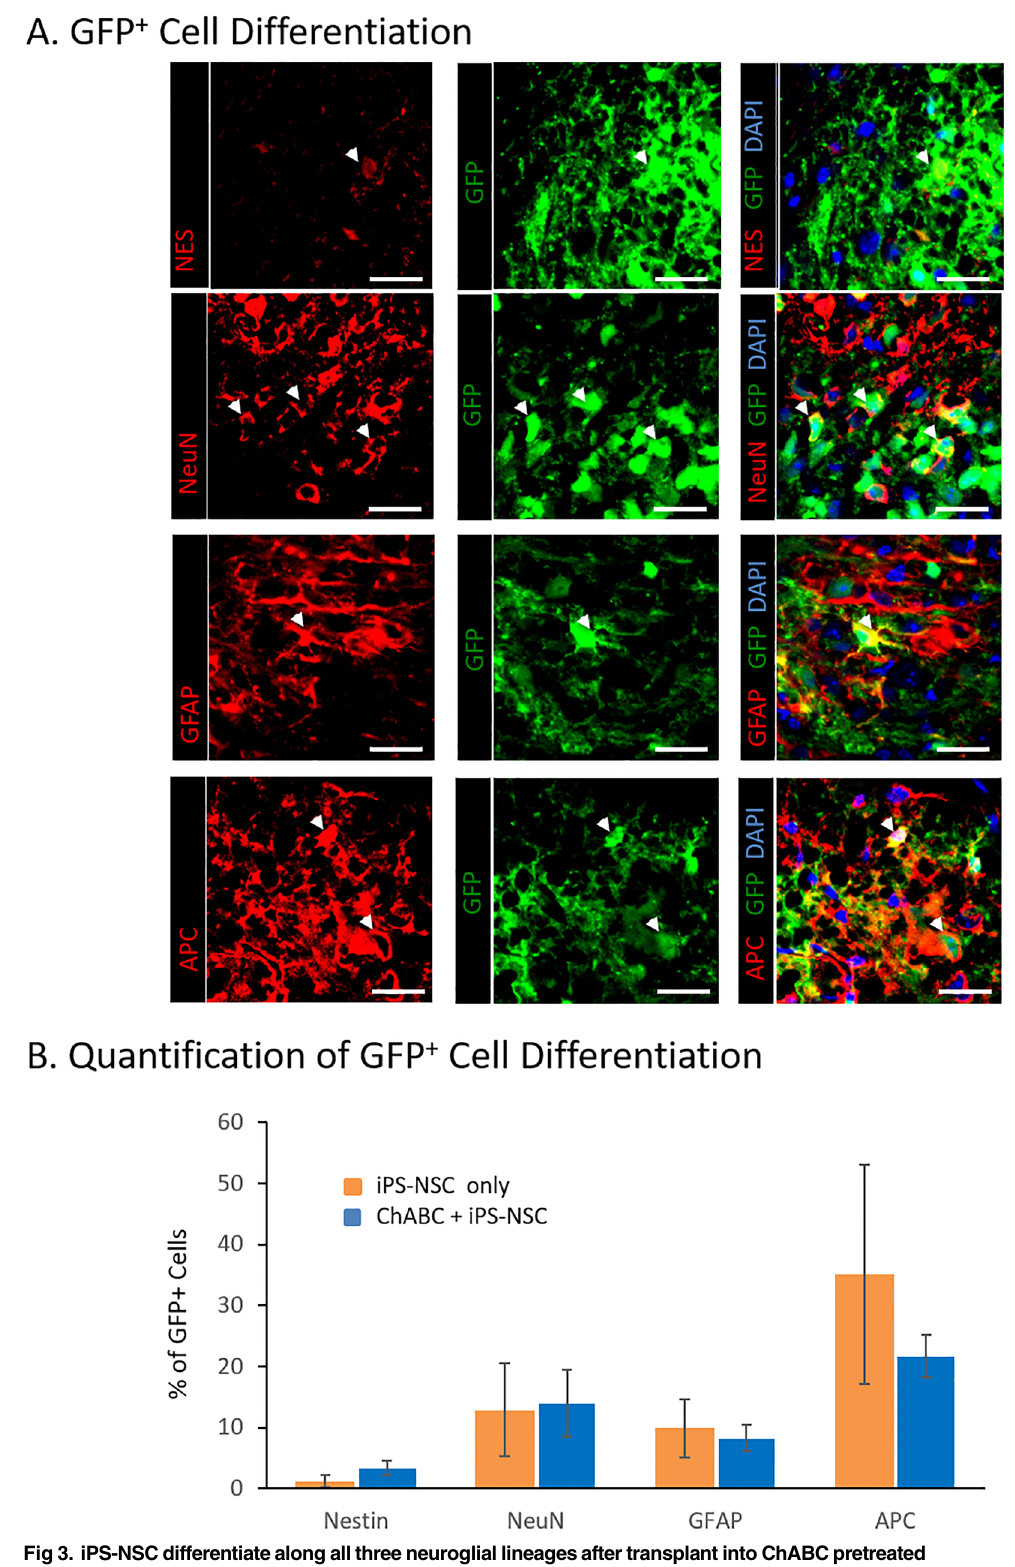
Fig 3. iPS-NSCdifferentiatealong all threeneuroglial lineagesaftertransplant into ChABCpretreated chronically injured spinal cords. (A) Immunofluorescenceimagingdemonstratingundifferentiatedneuralstem cells